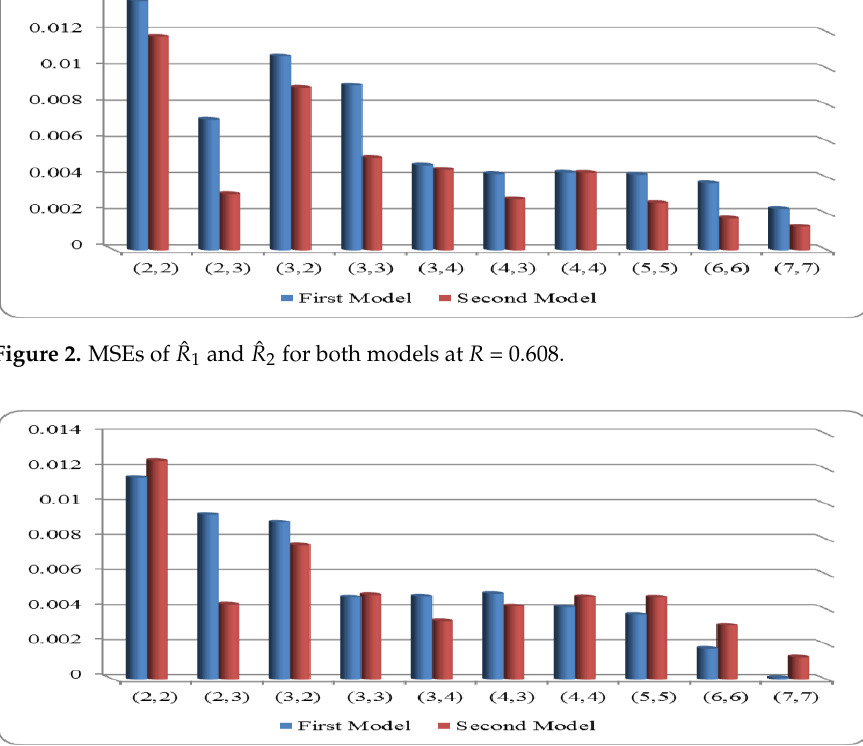
ˆ R and ˆ R for both models at R = 0.71. 1 2